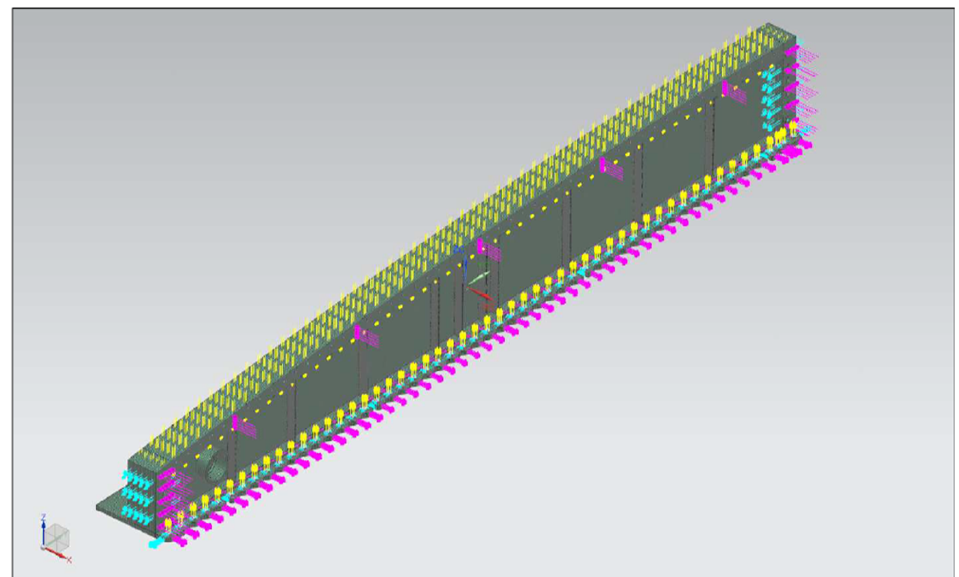
Figure 7. Material properties for the wing root joint.